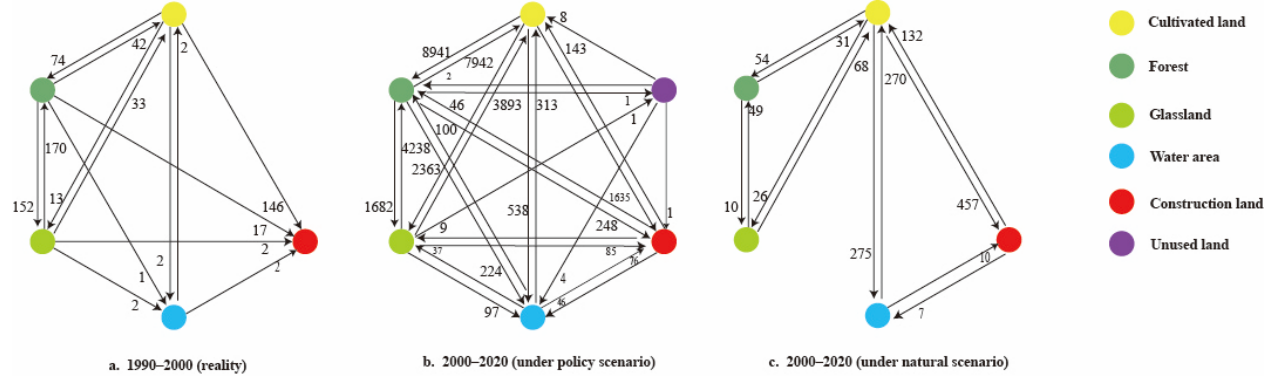
Figure 9. A complex network of land use changes in Chongqing. ( a ) 1990–2000 (reality) ( b ) 2000–2020 (under policy scenarios) ( c ) 2000–2020 (under natural scenarios). Table 6. Weighted in-degree and weighted out-degree of complex network nodes in 1990–2020 (unit: km 2 ).